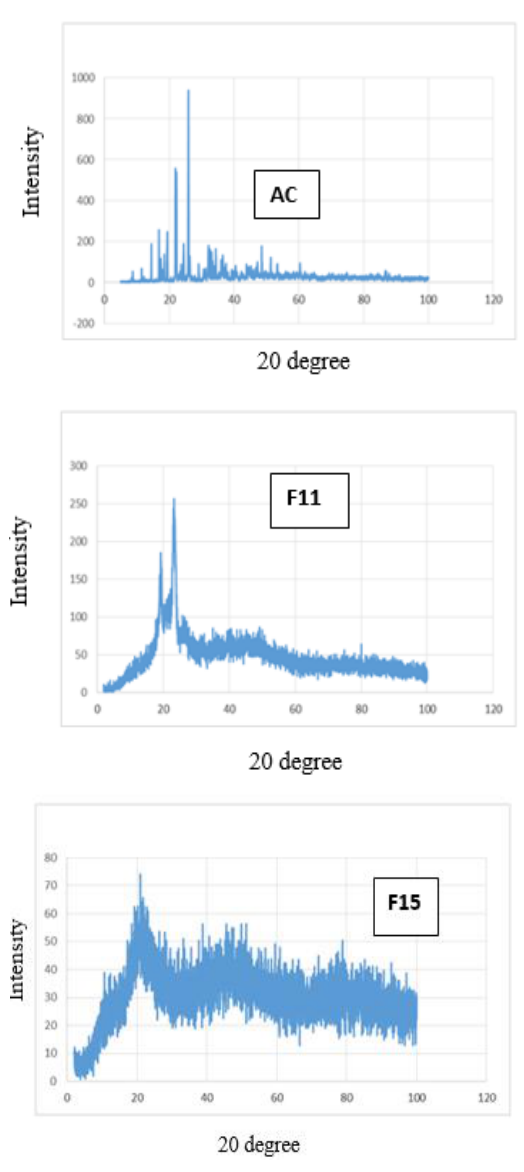
Figure 8. PXRD graphs for AC powder, F11 and